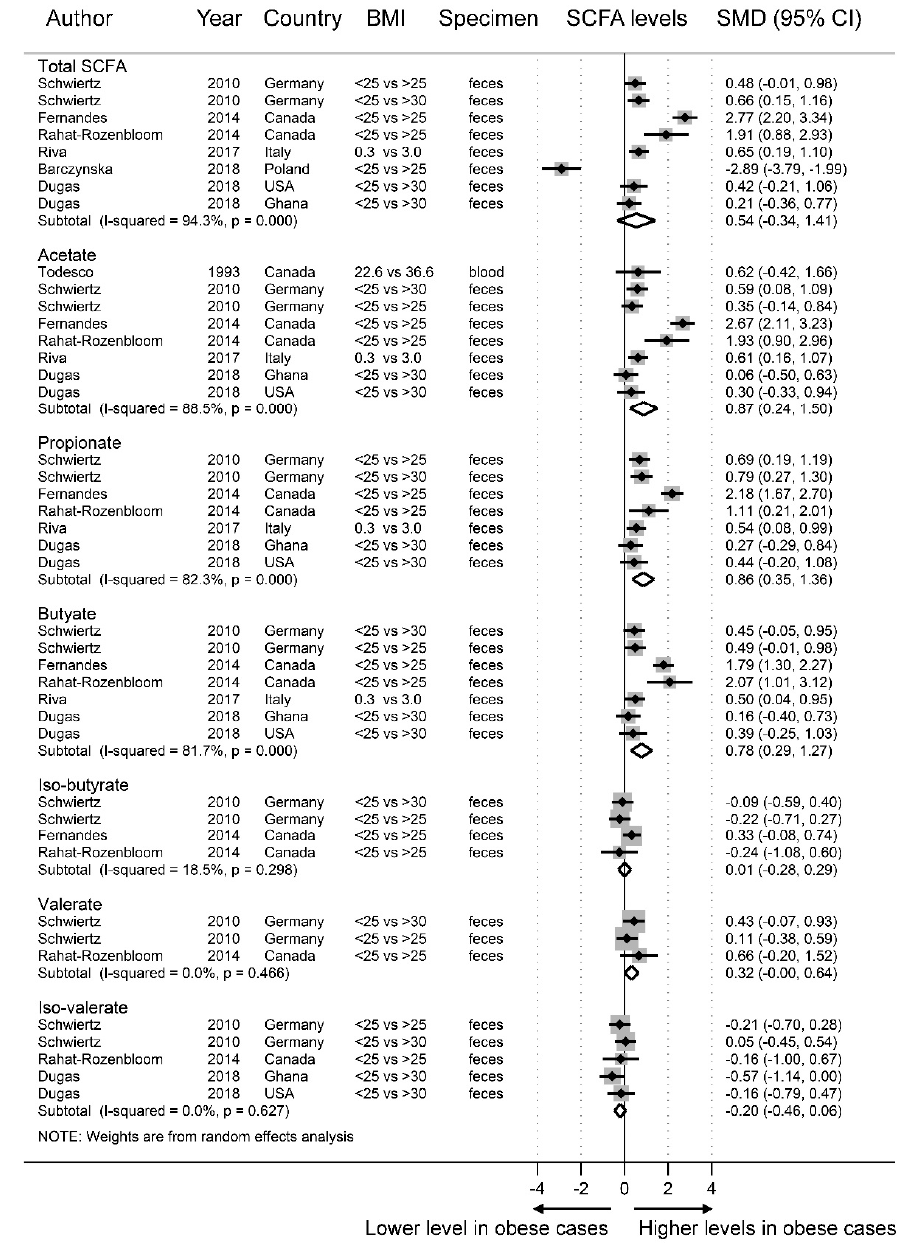
Figure 2. Forest plots of studies of short-chain fatty acid (SCFA) levels in obese and non-obese individuals. The combined standardized mean differences (SMD) and 95% confidence intervals (CIs) were calculated using random-effects models.